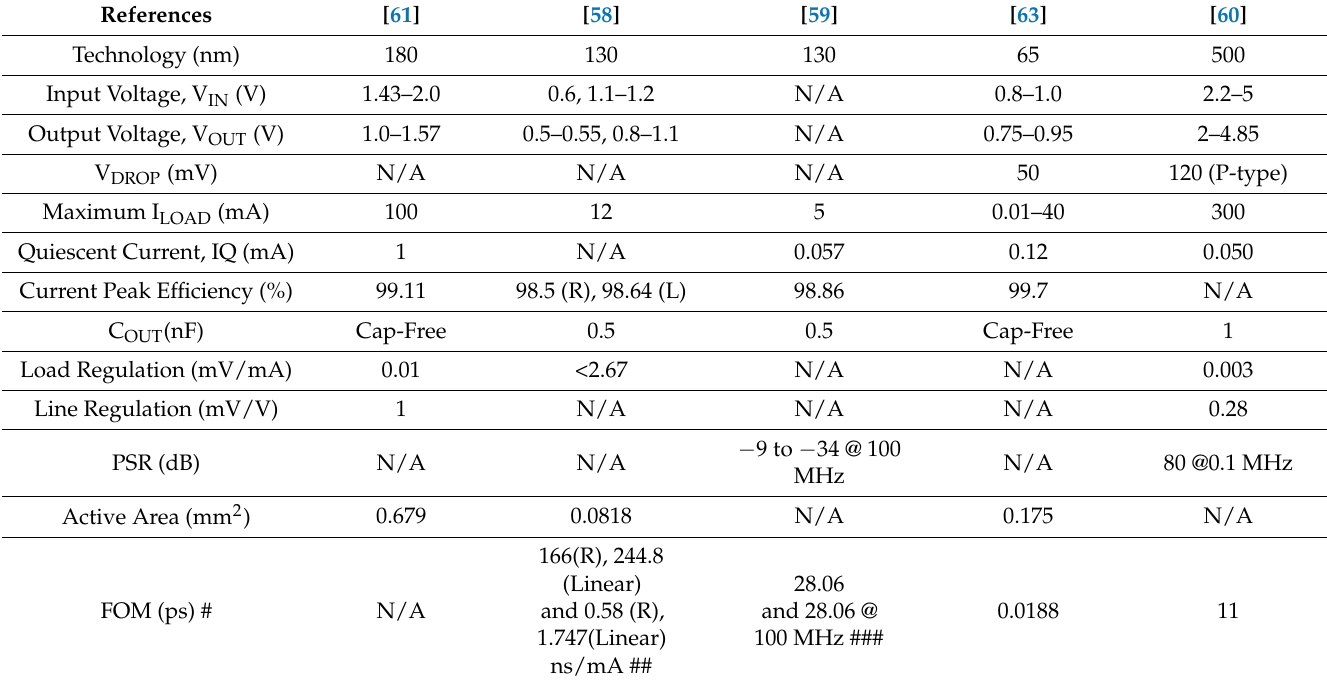
Table 3. Summary of the HD-LDO performance